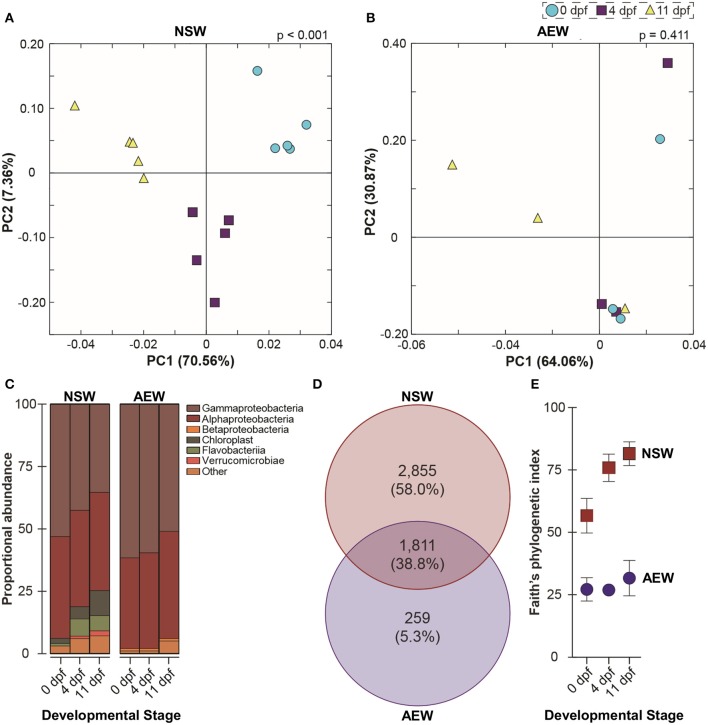
The natural seawater and laboratory microbiomes in early larval development. (A,B) UniFrac-weighted principal coordinate analysis of operational taxonomic units (OTUs) associated with zygotes, 4 dpf larvae, and 11 dpf larvae raised in natural seawater (NSW) and in the laboratory (AEW). (C) Relative class-level abundance profiles across early development in NSW- and AEW-exposed larvae. (D) Venn diagram illustrating NSW-specific, AEW-specific, and overlapping larva-associated bacterial OTUs. (E) Differential phylogenetic diversity (Faith's index) over early development in NSW- and AEW-reared zygotes and larvae.